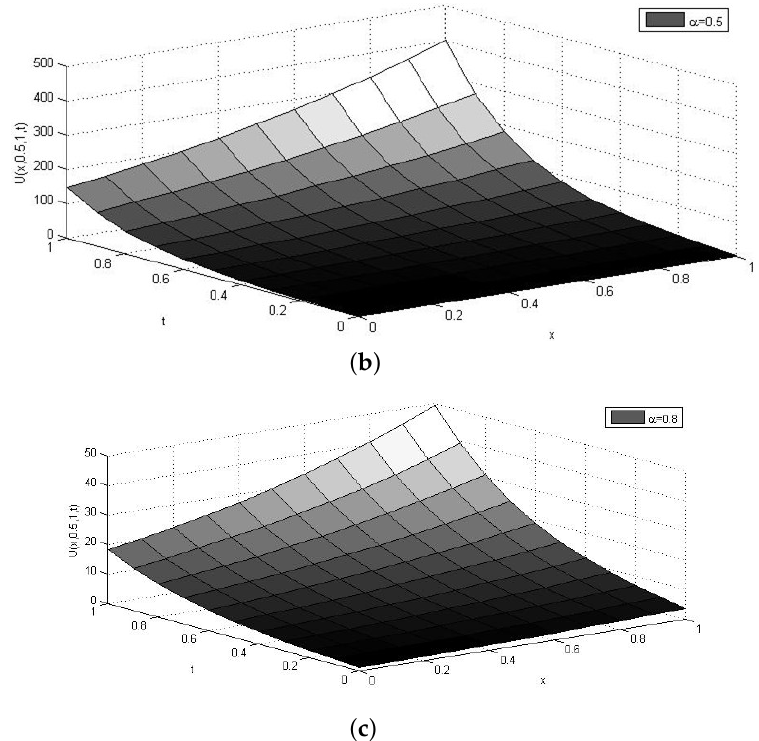
Figure 6. ( a ) Approximate solutions for different values of α ≤ 1. ( b ) Approximate solution for α = 0.5. ( c ) Approximate solution for α =